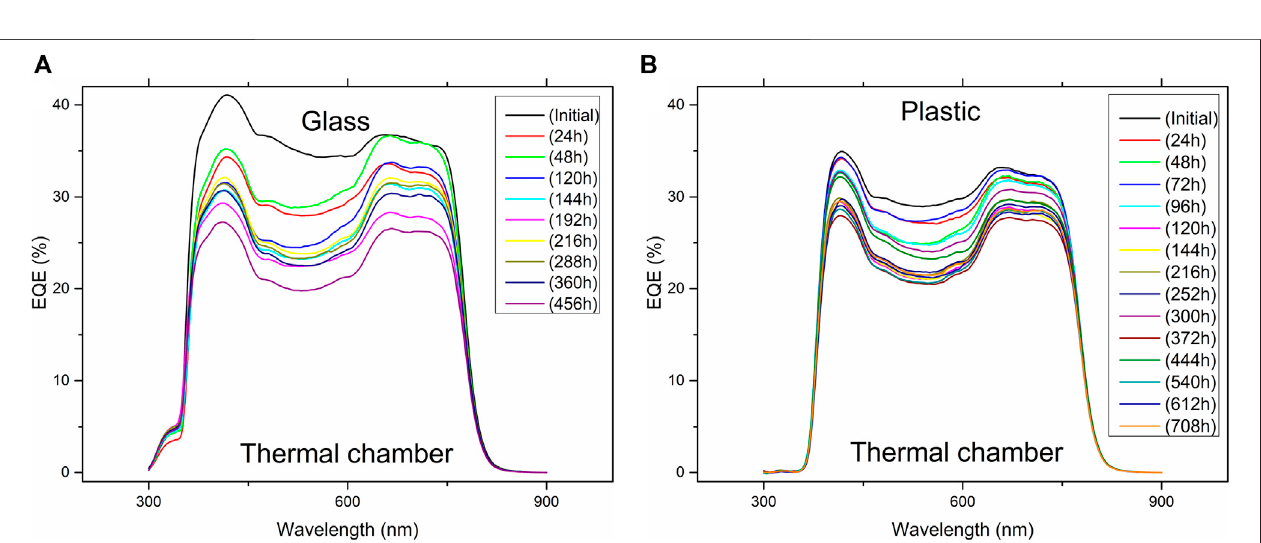
FIGURE 7 | Evolution of the EQE vs. time for ISOS-T-3 for both encapsulations (glass (A) and plastic (B) , respectively).